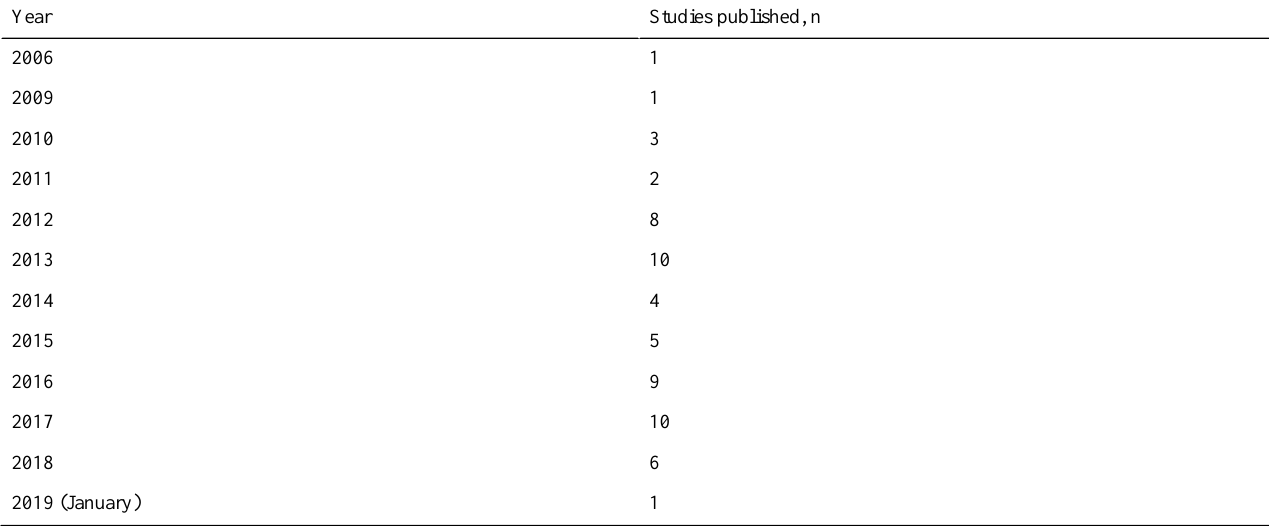
Table 2. Number of publications over time.